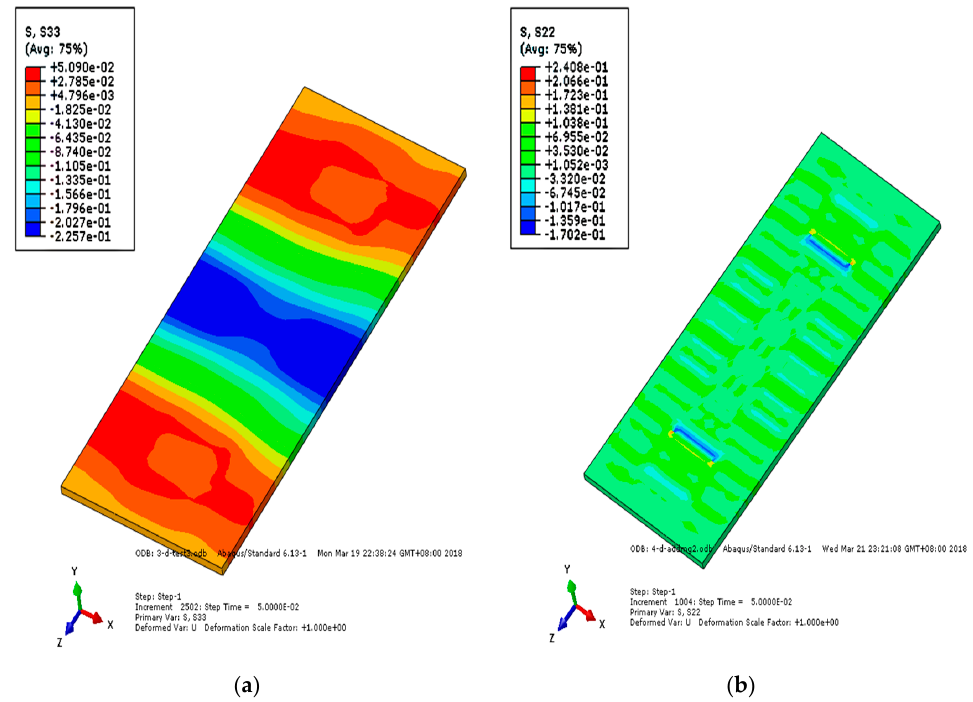
Figure 16. Stress nephogram of SCC under the action of axle falling: ( a ) longitudinal stress of SCC; ( b ) vertical stress of SCC.